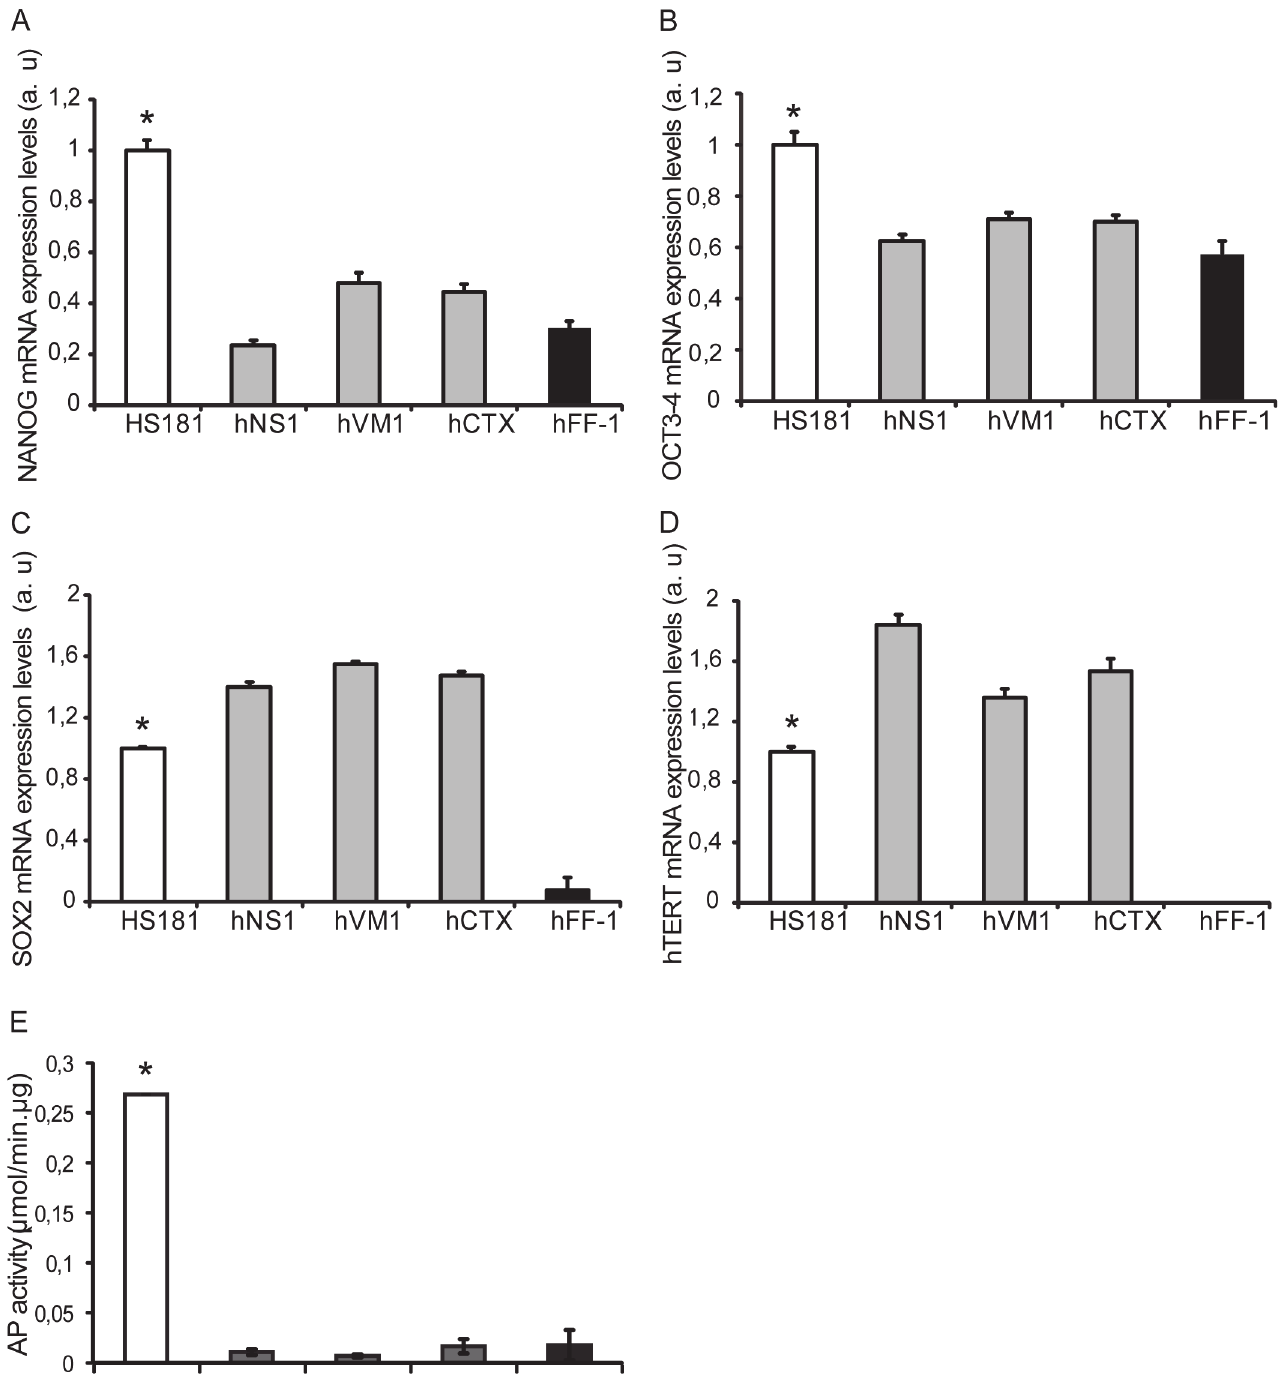
Fig 4. Expression of pluripotency markers and quantification of alkaline phosphatase activity. mRNA levels were quantified by RT-Q-PCR. NANOG (A), OCT3 – 4 (B), SOX2 (C) and hTERT (D) expression in the v-myc immortalized cell lines shows significant differences with the HS181 pluripotent cell line. Data are the average ± S.E.M (n = 4). * P < 0.05; one-way ANOVA, followed by a post-hoc LSD and Bonferroni test or non parametric Kruskal-Wallis and median test followed by a post-hoc multiple comparisons of mean ranks for all groups . E) Quantification of alkaline phosphatase activity in the cell lines. Data are the average ± S.E.M (n = 3). * P < 0.05; non parametric Kruskal-Wallis and median test followed by a post-hoc multiple comparisons of mean ranks for all groups .